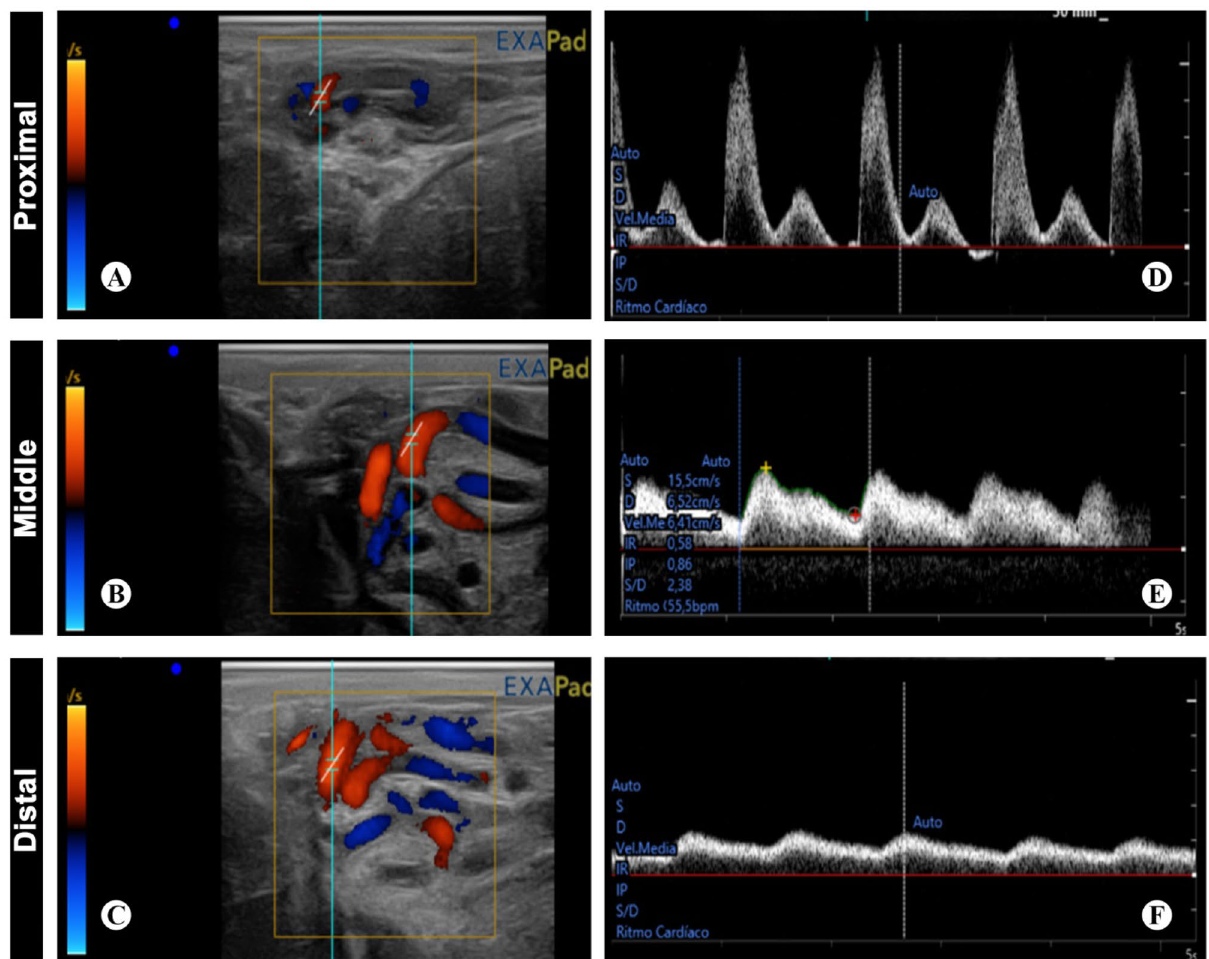
Figure 2. Cross section of the spermatic cord with color and pulse Doppler ultrasound. ( A , D ) proximal, ( B , E ) middle, and ( C , F ) distal supratesticular zones of the testicular artery illustrating Doppler parameters calculated by the ultrasound equipment’s